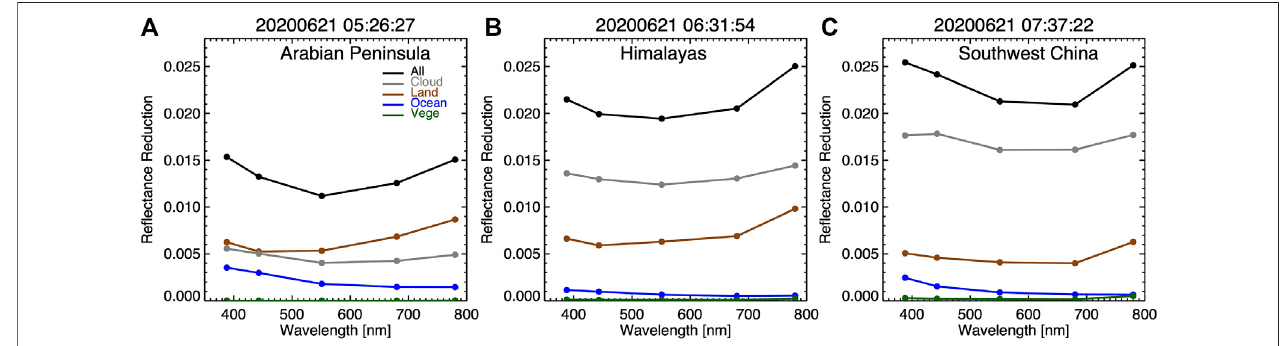
FIGURE 7 | Disk average re fl ectance reduction with contributions from different re fl ector types for the 2020 solar eclipse when the center of the Moon ’ s shadow was in (A) Arabian Peninsula, (B) Himalayas, (C) Southwest China.